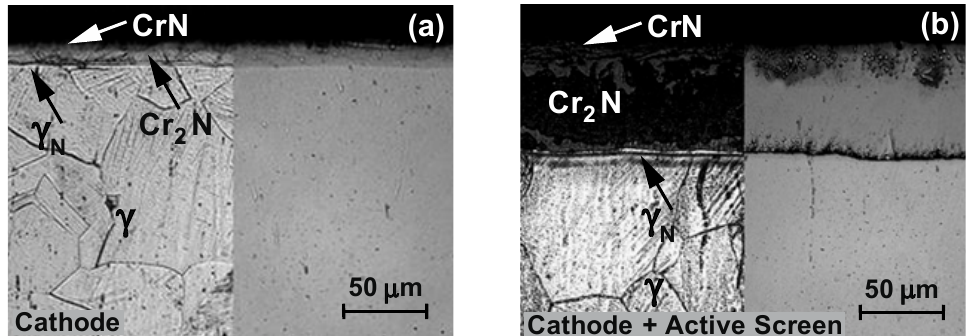
Figure 7. Microstructure of nitrided layers on the 316L steel substrate, temperature T = 490 °C, time t = 14 h; ( a ) cathode, ( b ) cathode + active screen. t = 14 h; ( a ) cathode, ( b ) cathode + active